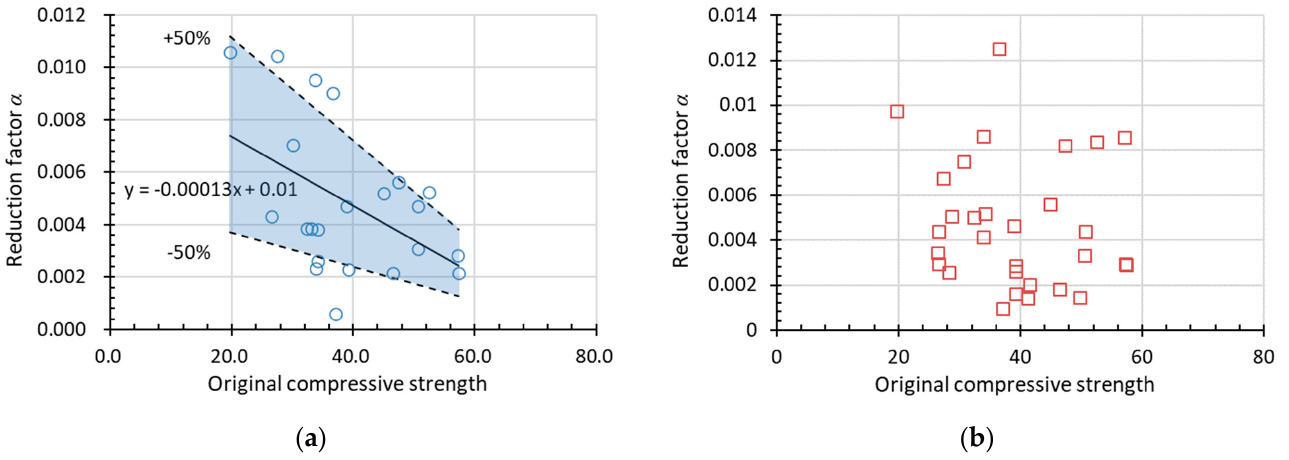
Figure 16. Factor α in the linear function in terms of original compressive strength for ( a ) RDEM and ( b ) Rf c of non-air-entrained concrete.